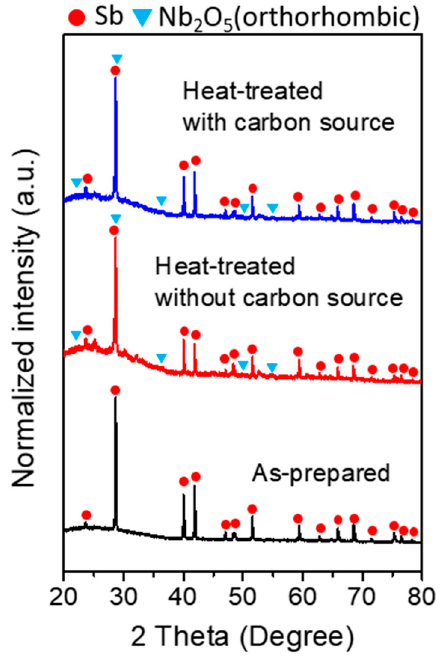
Figure 2. XRD patterns of as-prepared and composite after heat treatment with and without a carbon source.